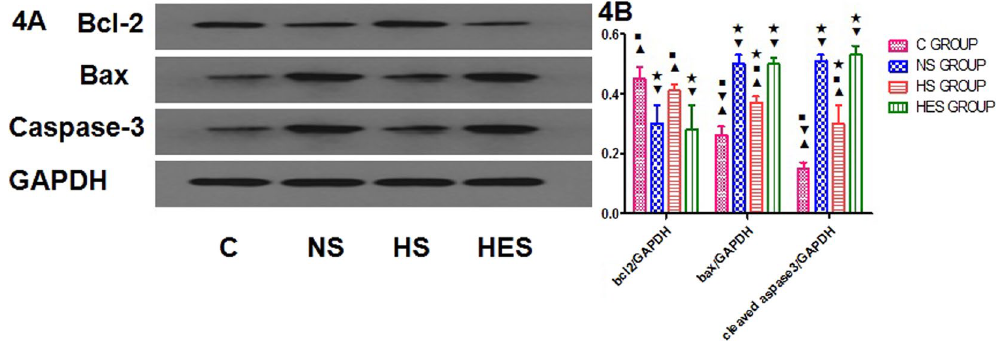
Figure 4. Expression of apoptosis protein, Bcl-2, Bax and Caspase-3 by Western bolt. Apoptosis protein Bcl-2, Bax and Caspase-3 by Western blot analysis (Fig. 4A, cropped gels/blots, full-length gels/blots are included in the Supplementary Information file) and quantitative analysis (Fig. 4B). ★ P < 0.05 vs control group; ◾ P < 0.05 vs